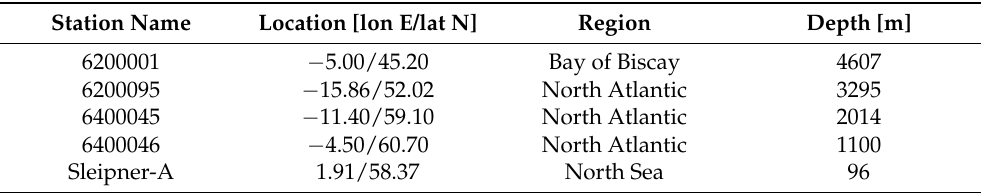
Table A1. In situ stations used in the validation of CryoSat-2, as well as their locations and lo- cal